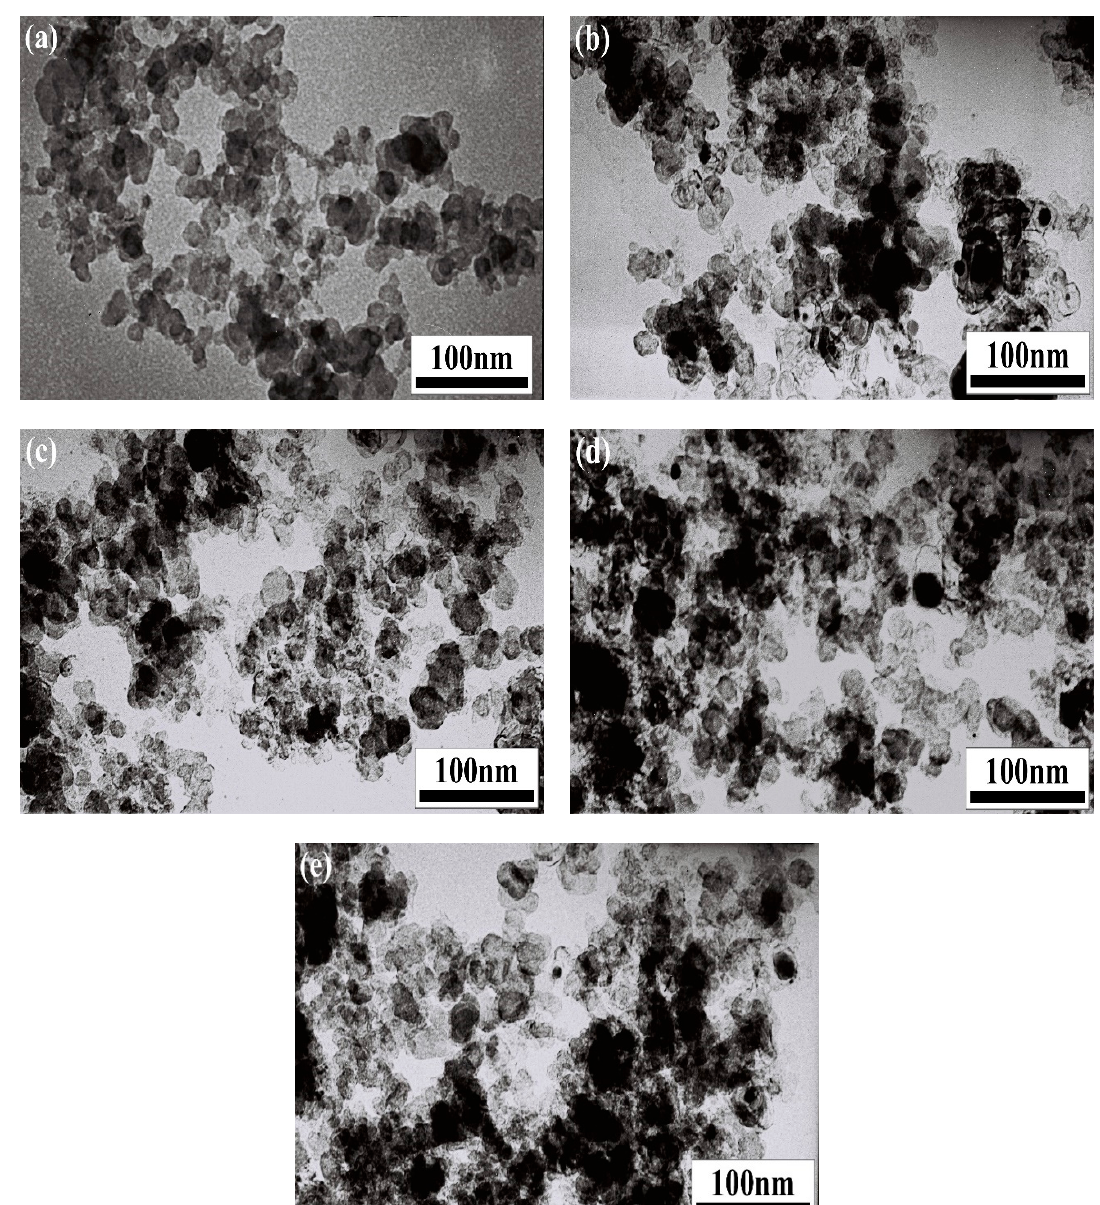
Figure 3. TEM micrographs of the powders before and after microwave heating: ( a ) before microwave heating; ( b ) 0.5 h; ( c ) 1 h; ( d ) 1.5 h; ( e ) 2 h.